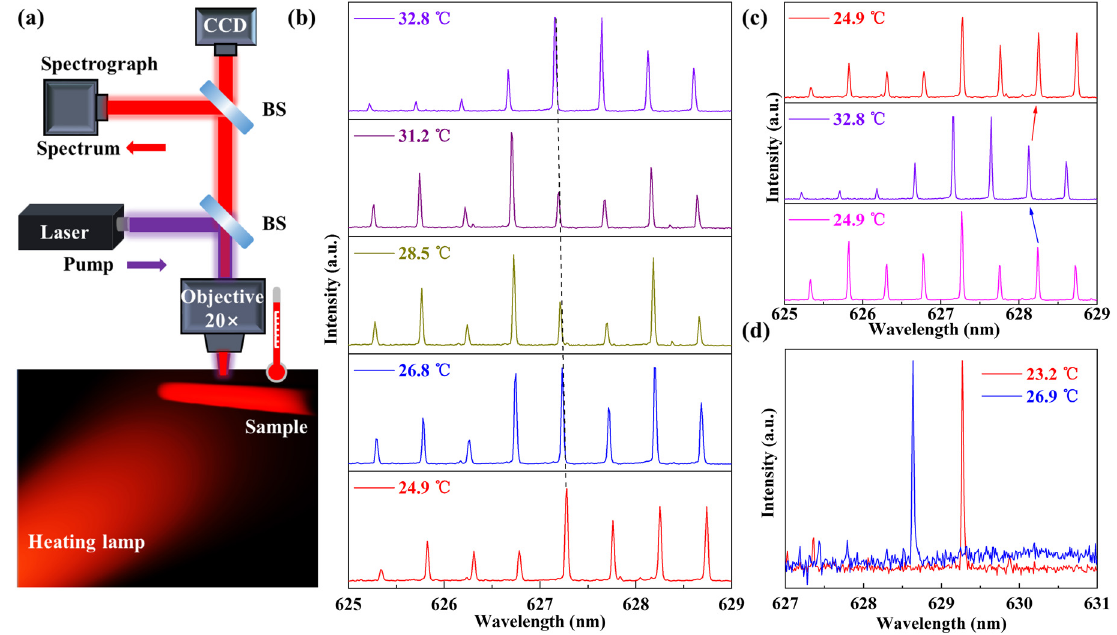
Figure 5: Tunability of the WGM peak wavelength for temperature sensing. (a) Schematic diagram of the temperature sensing experimental setup. Inset: schematic diagram wavelength tuning achieved by controlling the environment temperature ( ° C). BS: beam splitter. (b) The evolution of PL spectrum is blue-shifting with increasing temperature. (c) The temperature sensor is reversible. (d) The single-mode is blue-shifting with increasing the environment temperature ranging from 23.2 ° C to 26.9 ° C in hybrid 2D – 3D μ